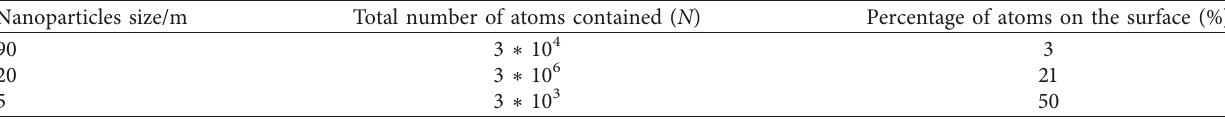
Table 1: The relationship between the size of nanoparticles and the number of atoms on the surface. Nanoparticles size/m Total number of atoms contained ( N